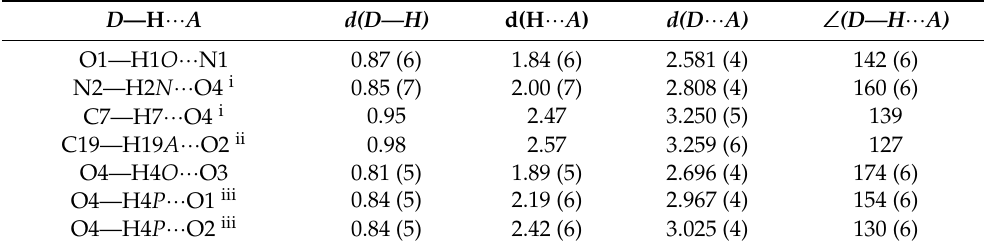
Table 4. Hydrogen-bond geometry with selected bond lengths (Å) and bond angles ( ◦